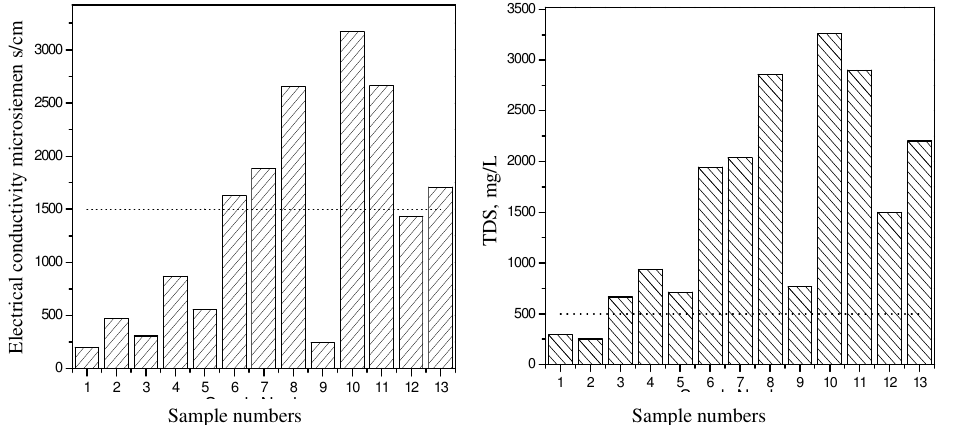
Figure 1. Electrical conductivity in the water samples (Dotted line indicates the permissible limit).